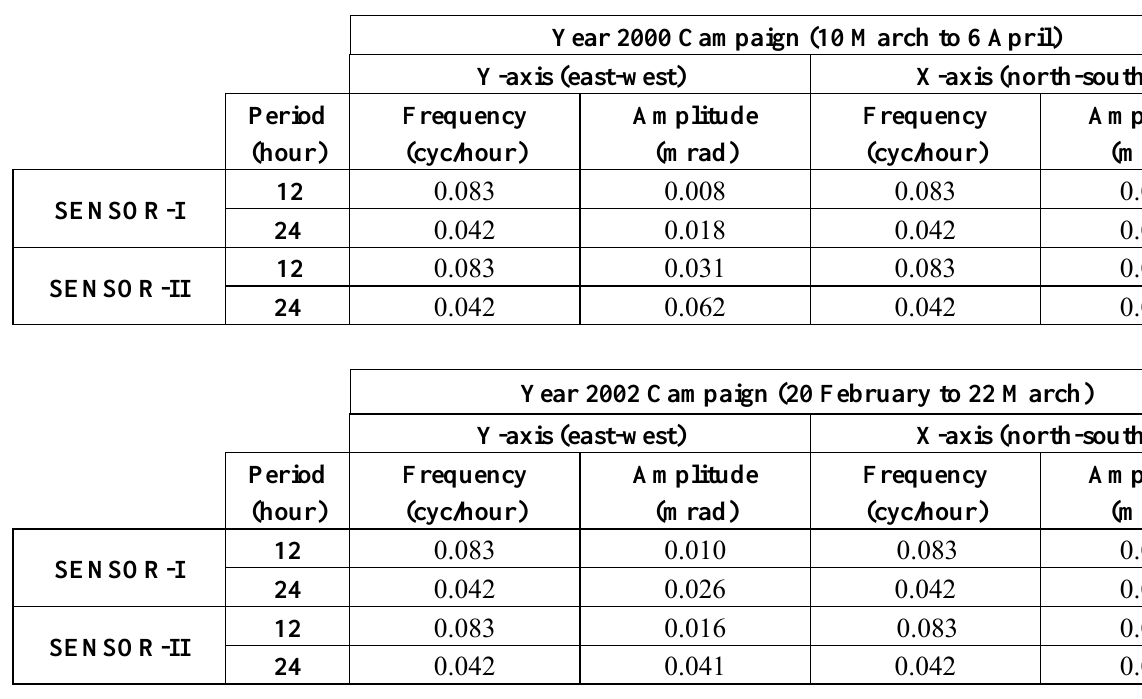
Table 5. Overall LSSA results of inclination data: geodetic pillar (S-II) and host building (S-I).